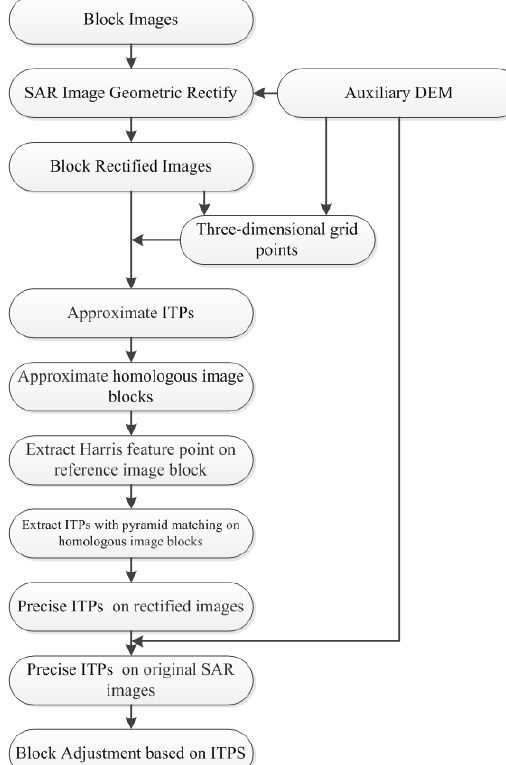
Figure 1. Automatic Extraction of ITPs